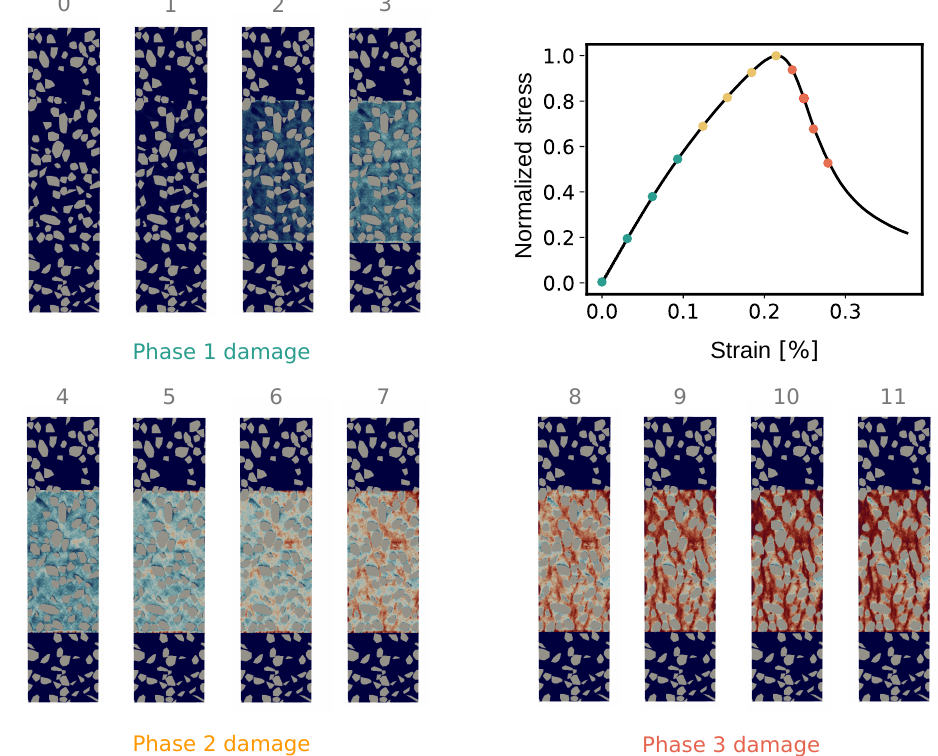
Figure 3. Damage evolution of the concrete sample subjected to uniaxial compression. Legend: grey color — aggregate, blue color — undamaged mortar, red color — damaged mortar. Top right: normalized stress-strain curve obtained from the DEM simulation. The corresponding load levels at which the microstructure snapshots are extracted are highlighted by colored dots (see Table 2 for the strain levels of each damage